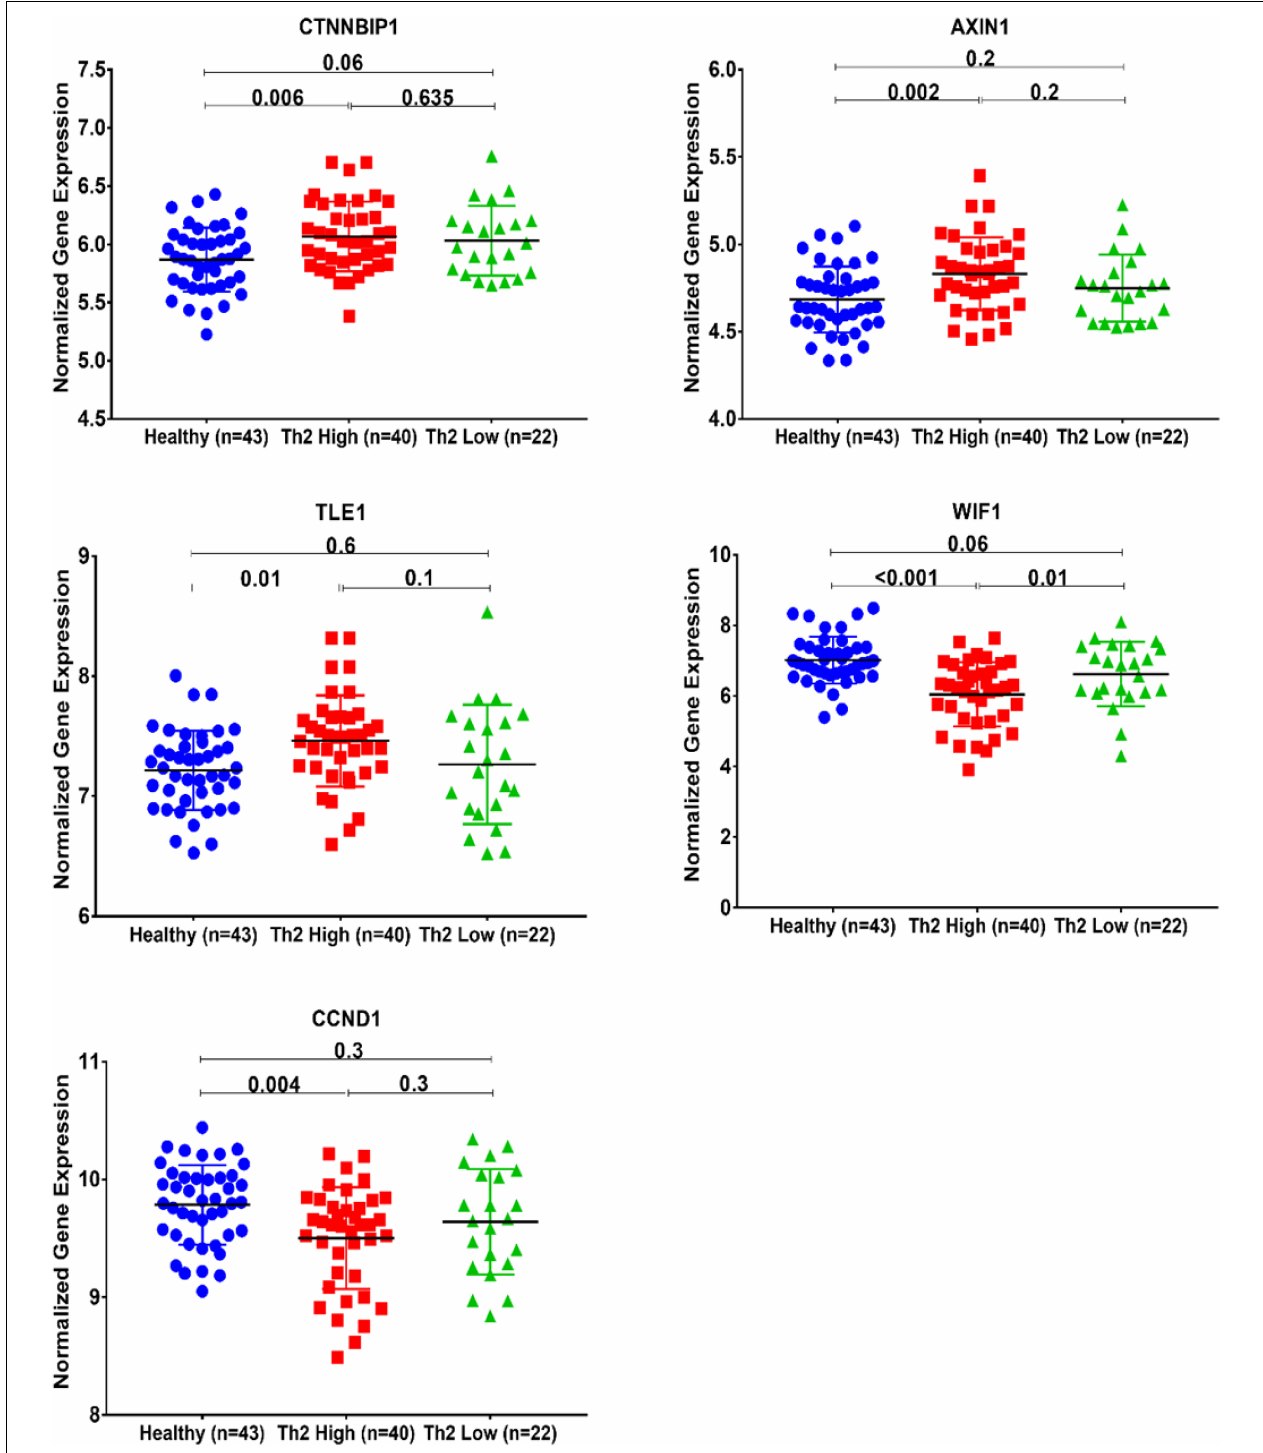
FIGURE 5 | Normalized gene expression of Wnt signaling pathways identified to be differentially expressed between Th2-high and healthy asthmatic bronchial epithelium transcriptomics data of the GSE67472 dataset to compare healthy controls ( n = 43) to Th2-high asthmatics ( n = 40) and Th2-low asthmatics ( n = 22).